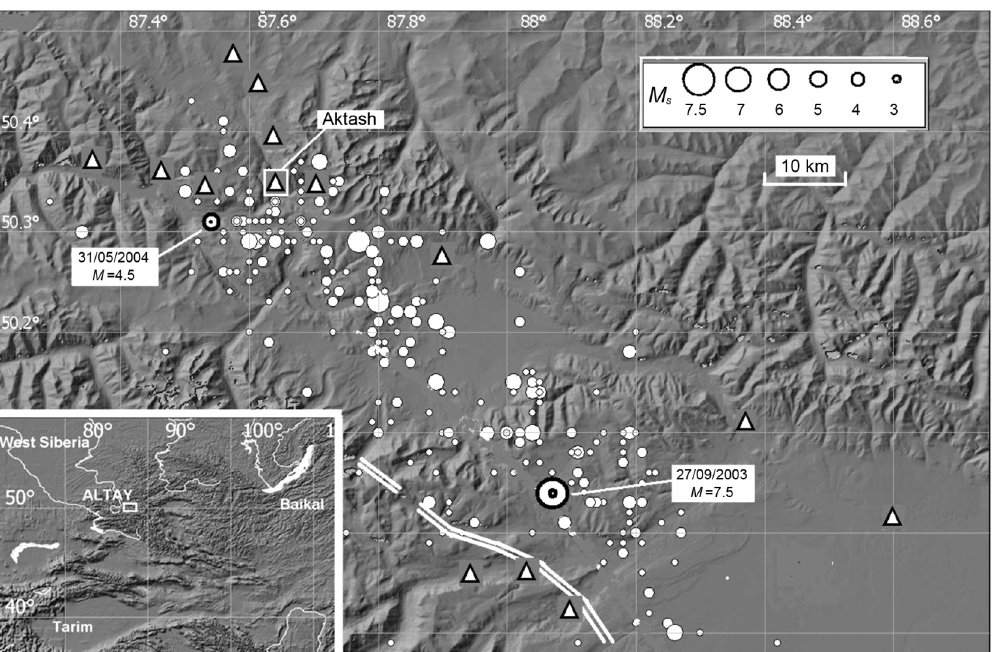
Fig. 1. Array of repeated-survey tectonomagnetic stations (triangles) and epicenters of M > 3 aftershocks of the M = 7.5 Altay earthquake of 27 September 2003 (circles). Triangles show repeated-survey sites and boxed trian- gle shows the continuous station. Double white line delineates the fault scarp produced by the Altay earthquake. Inset shows location map of study